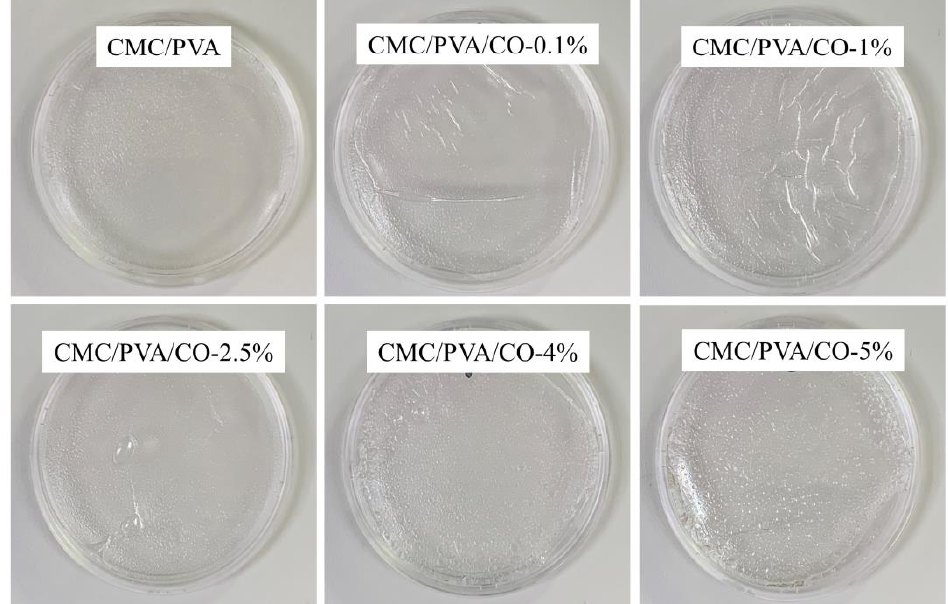
Figure 1. Visual appearance of the CMC/PVA/CO composite films.